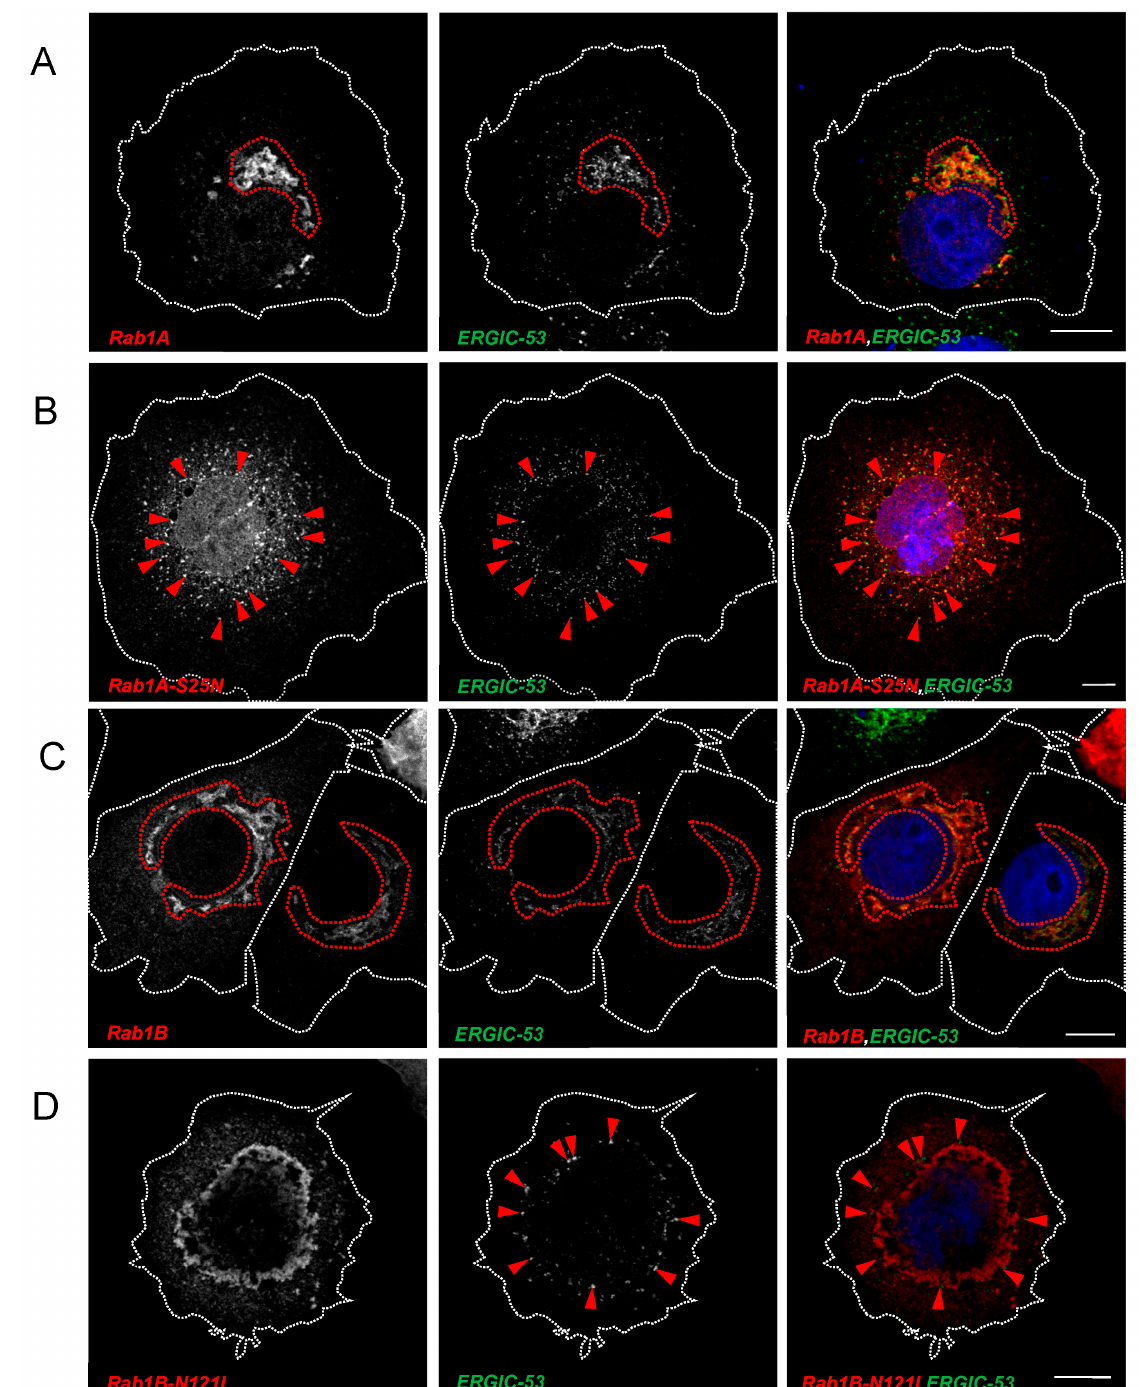
Figure 7. Overexpression of Rab1 DN mutants impairs the structural integrity of the ERGIC. Colocal- ization analysis of Rab1A, Rab1B and corresponding DN mutants in HuH7 cells with endogenous ERGIC-53. Subconfluent HuH7 cells were transfected with 750 ng ( A ) pCMV-Rab1A-myc, ( B ) pCMV- Rab1A-S25N-myc, ( C ) pCMV-Rab1B-myc or ( D ) pCMV-Rab1B-N121I-myc, respectively. Cells were fixed 24 hpt and stained for endogenous ERGIC-53 (green), Rab1A/Rab1B (anti-myc, red) and nuclei (blue) with DAPI. Scale bars indicate 10 µ m. Encircled area marks organized ERGIC and arrows demonstrate scattered ERGIC. ERGIC-53 single staining can be found in Figure S4C. Data are representative of three independent